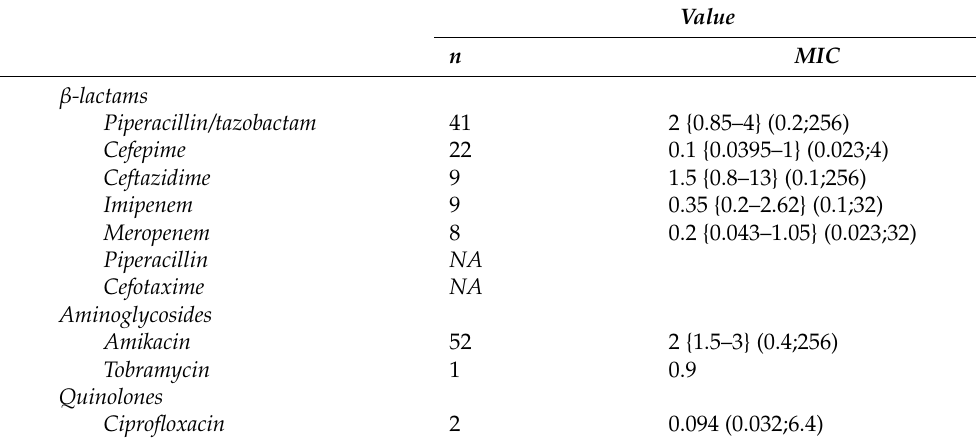
Table 3. Median MICs of each antibiotic for all GNB species identified above cut-off values for respiratory samples and treated with the antibiotic of concern.